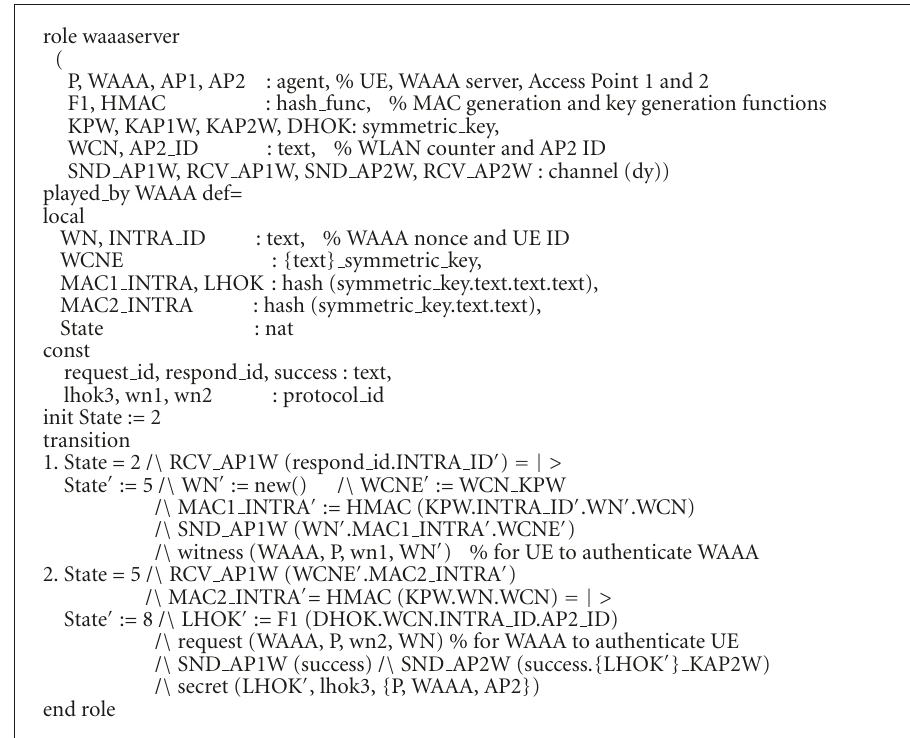
Figure 13: HLPSL code describing WAAA’s role in Intra-WLAN